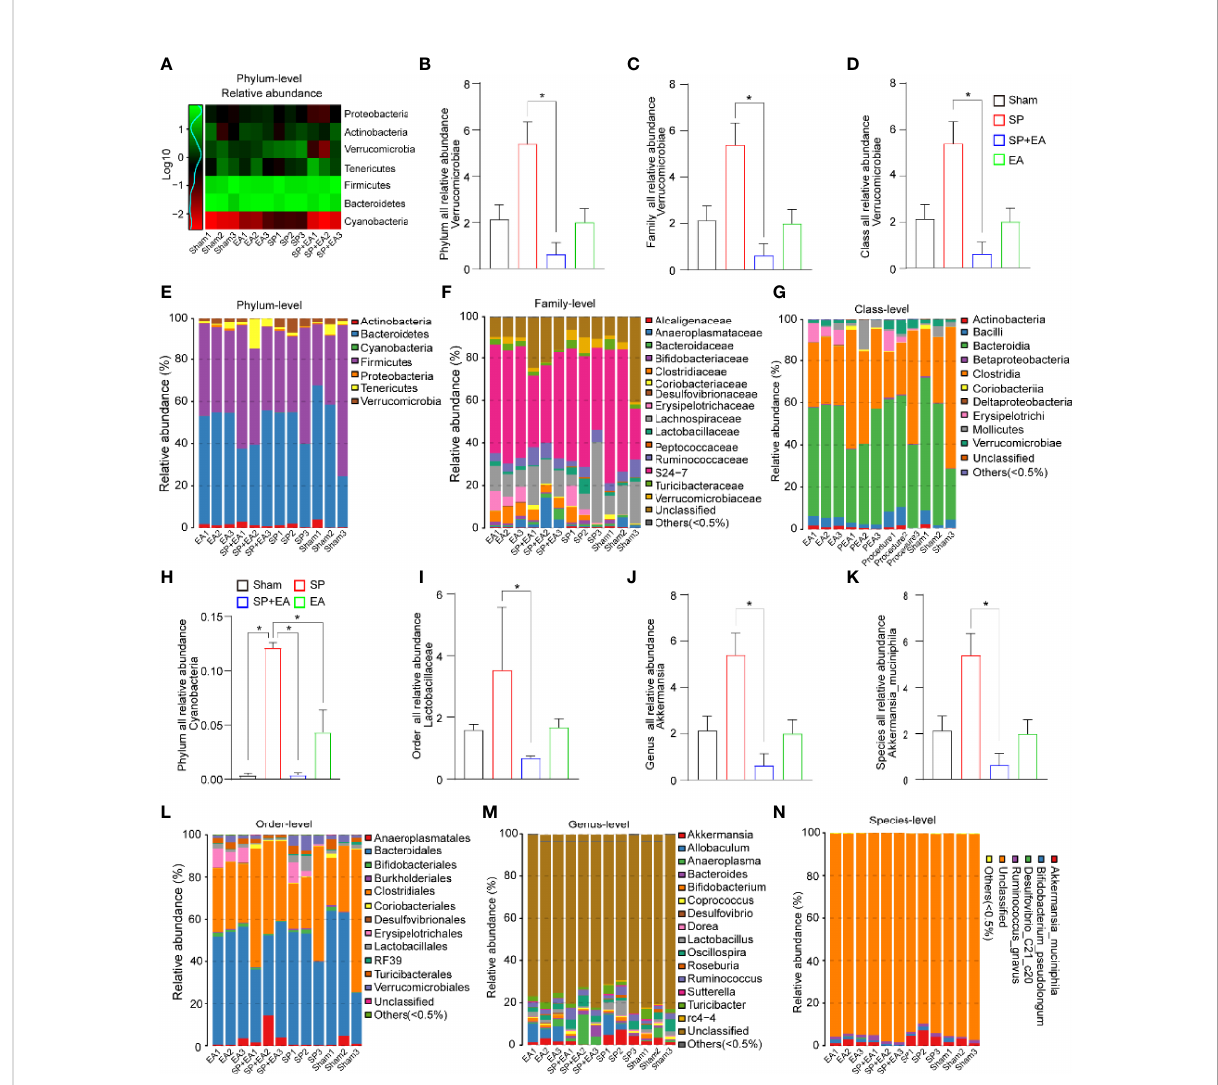
FIGURE 3 EA (DU20+KI1) attenuates the SP-induced changes in gut microbiota in mice. (A) Log-scaled percentage heatmap of phylum level. (B-G) SP increased the abundance of Verrucomicrobia at the phylum, family, and class levels. EA mitigated such increases. The p -values indicate the difference in the abundance between SP and SP plus EA ( n = 3, one-way ANOVA followed by Bonferroni post-hoc analyses). (H) SP increased the abundance of Cyanobacteria at the phylum level indicated in (E) . EA mitigated such increases. The p -values indicate the difference in the abundance between SP and SP plus EA ( n = 3, one-way ANOVA followed by Bonferroni post-hoc analyses). (I – L) SP increased the abundance of Lactobacillales at the order level. EA mitigated such increases. The p -values indicate the difference in the abundance between SP and SP plus EA ( n = 3, one-way ANOVA followed by Bonferroni post-hoc analyses). (J, K, M, N) The taxonomic composition distribution in samples at genus and species level. SP increased the abundance of Akkermansia at the genus level. EA mitigated such increases. The p -values indicate the difference in the abundance between SP and SP plus EA ( n = 3, one-way ANOVA followed by Bonferroni post-hoc analyses). Data are represented as mean ± SEM. * p < 0.05. SP, surgical pain; EA, electroacupuncture; SEM, standard error of